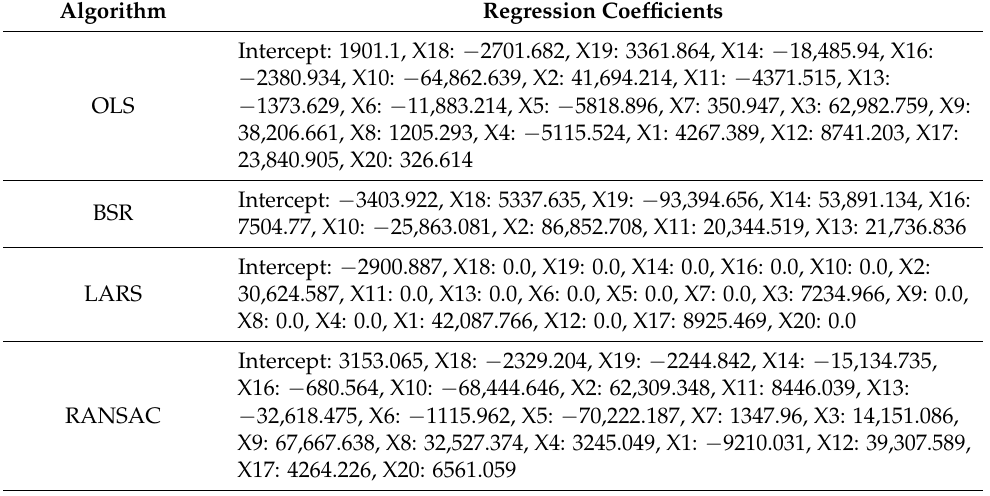
Table 6. Fitted models for population density regression in the subdistrict